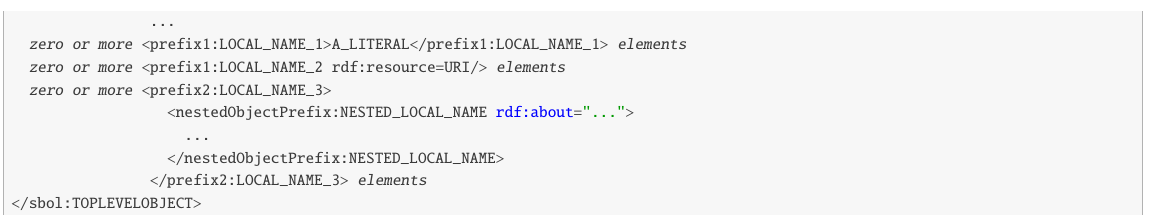
Figure 20: Diagram of the Annotation class and its association with Identified and AnnotationValue objects, which is used for annotating SBOL entities with application specific data.